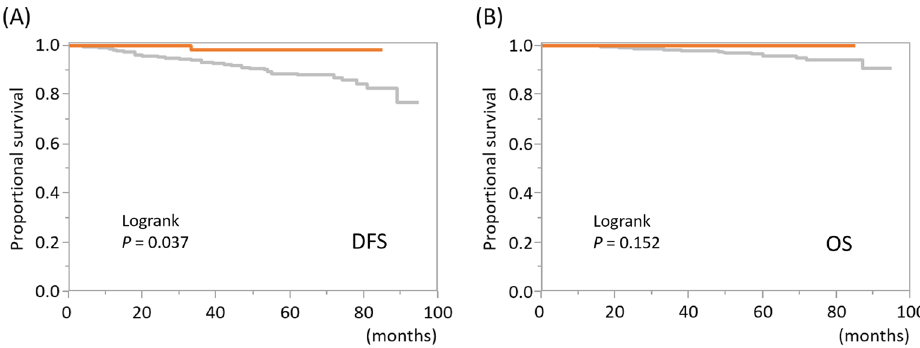
Figure 3. Kaplan–Meier curves of patient outcomes according to MUC1 staining pattern. Kaplan–Meier curves of ( A ) disease-free survival (DFS) and ( B ) overall survival (OS) according to MUC1 staining pattern are shown. Orange curves indicate patients with tumors with an apical MUC1 staining pattern, while grey curves indicate patients with tumors with other staining